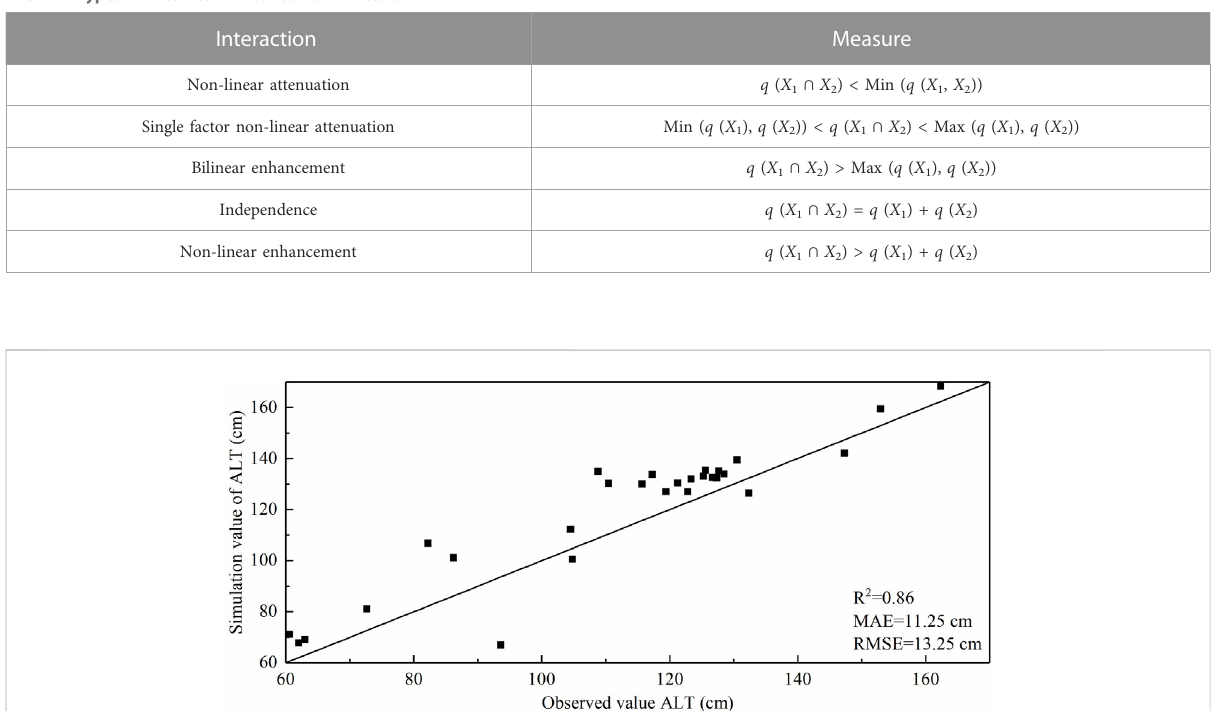
TABLE 2 Types of interaction between two factors.